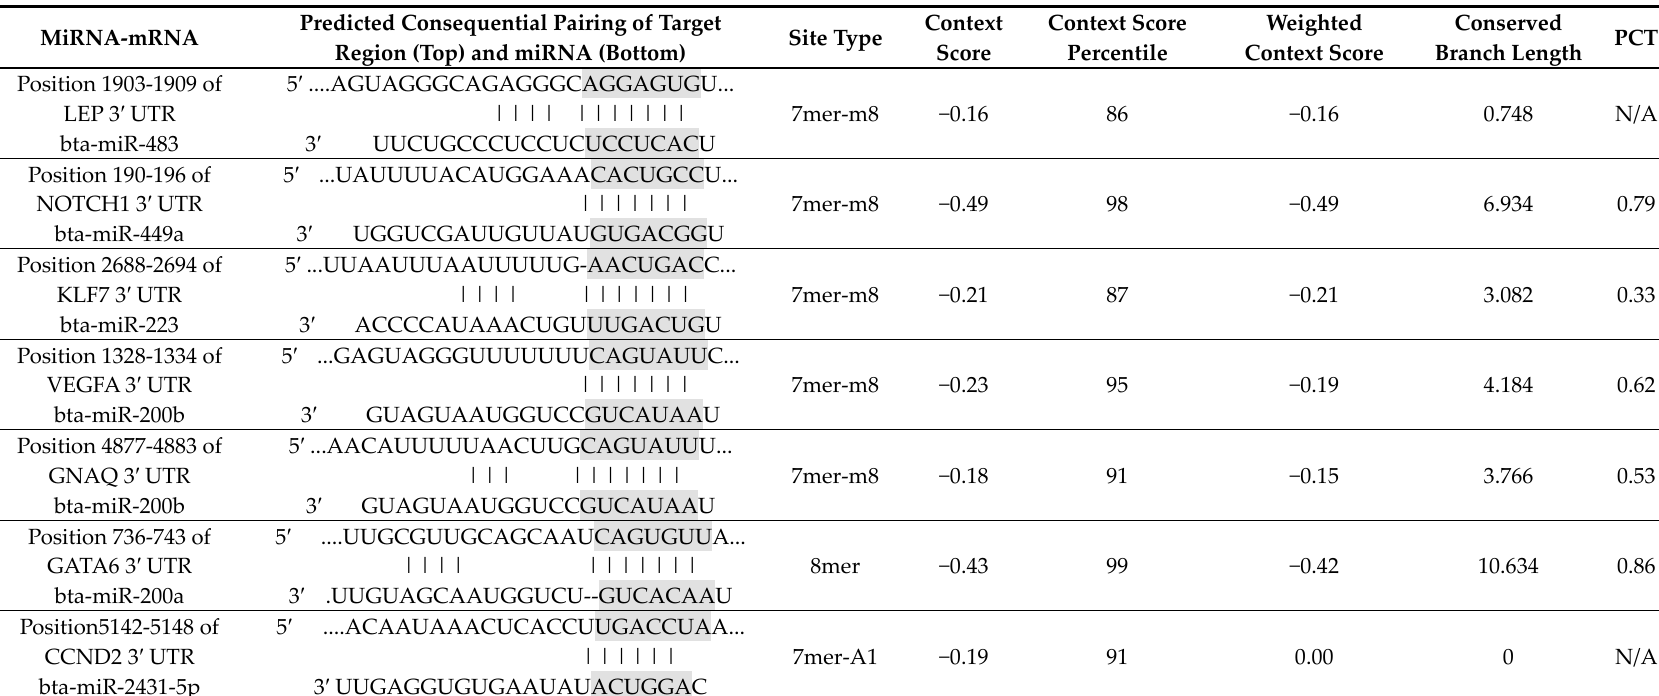
Table 7. The matching results of the differential miRNA and the target gene were obtained by using Target Scan software. Predicted Consequential Pairing of MiRNA-mRNA